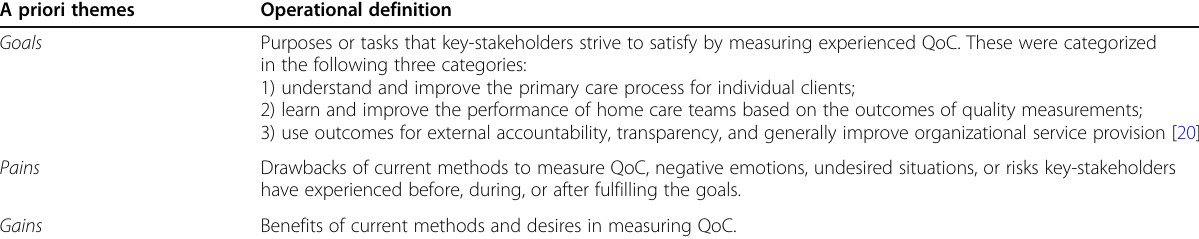
Table 1 A priori themes and operational definitions, based on the VPC